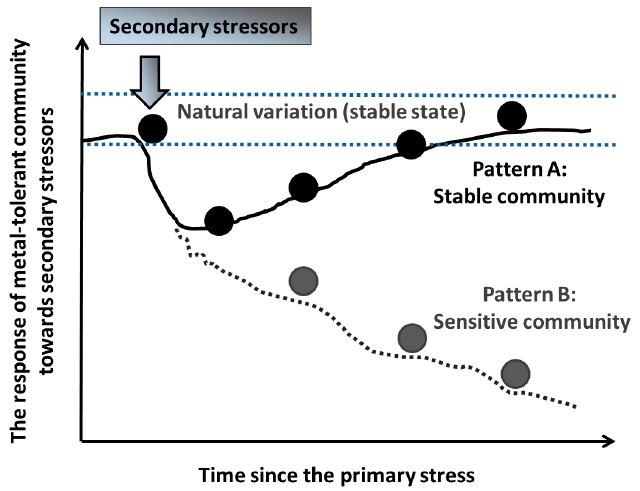
Figure 1. Conceptual figure showing the stability and/or sensitivity of metal-tolerant microbial communities that have been chronically exposed to metals and then face a secondary stressor. Pattern A: Stable community —A metal-tolerant community exhibits increased stability and resistance to secondary stressors; Pattern B: Sensitive community —Results from energetic trade-offs between resistance to different stressors or negative correlations between the traits determining the ability of microbial communities to withstand different stressors (for explanations, see text).